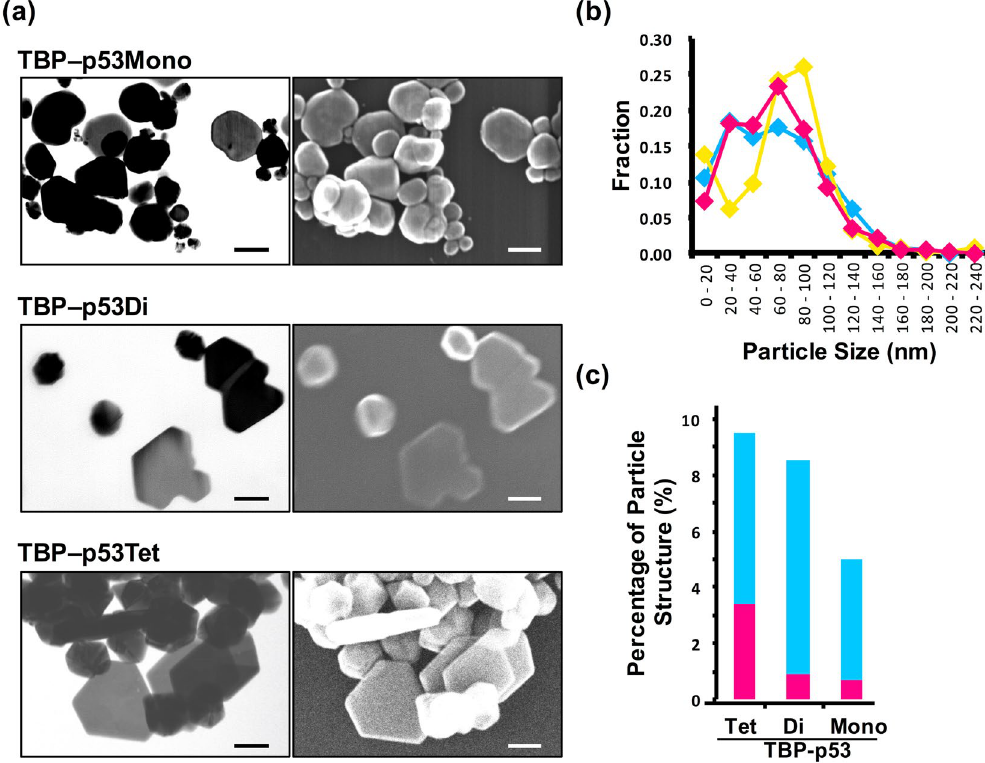
Figure 3. ( a ) Representative electron microscopy images of silver nanostructures formed by using TBP ‒ p53Mono, TBP ‒ p53Di and TBP ‒ p53Tet. Left panels are TEM mode images, and right panels are SEM mode images of STEM. The scale bar is 100 nm. ( b ) Size distribution line graph of silver nanostructures formed by using TBP ‒ p53Tet (red), TBP ‒ p53Di (yellow) and TBP ‒ p53Mono (blue). ( c ) Percentages of silver nanoplates